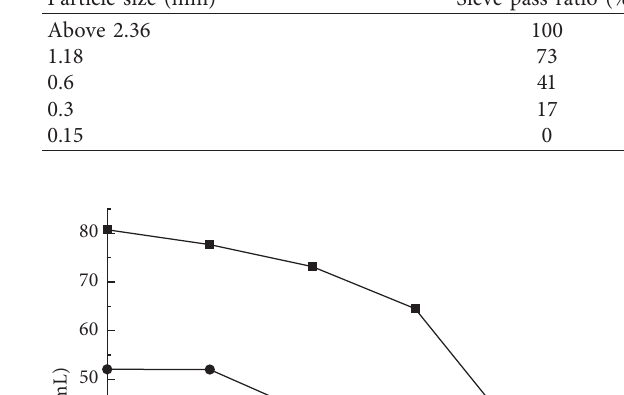
Table 3: Average value of retained water before and after the rutting